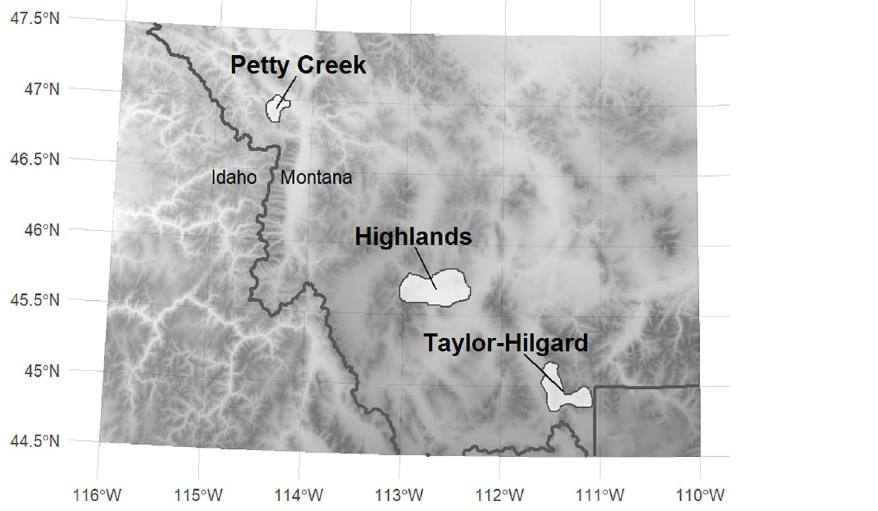
Fig 1. Study area map. The locations of bighorn sheep herds used as examples in this